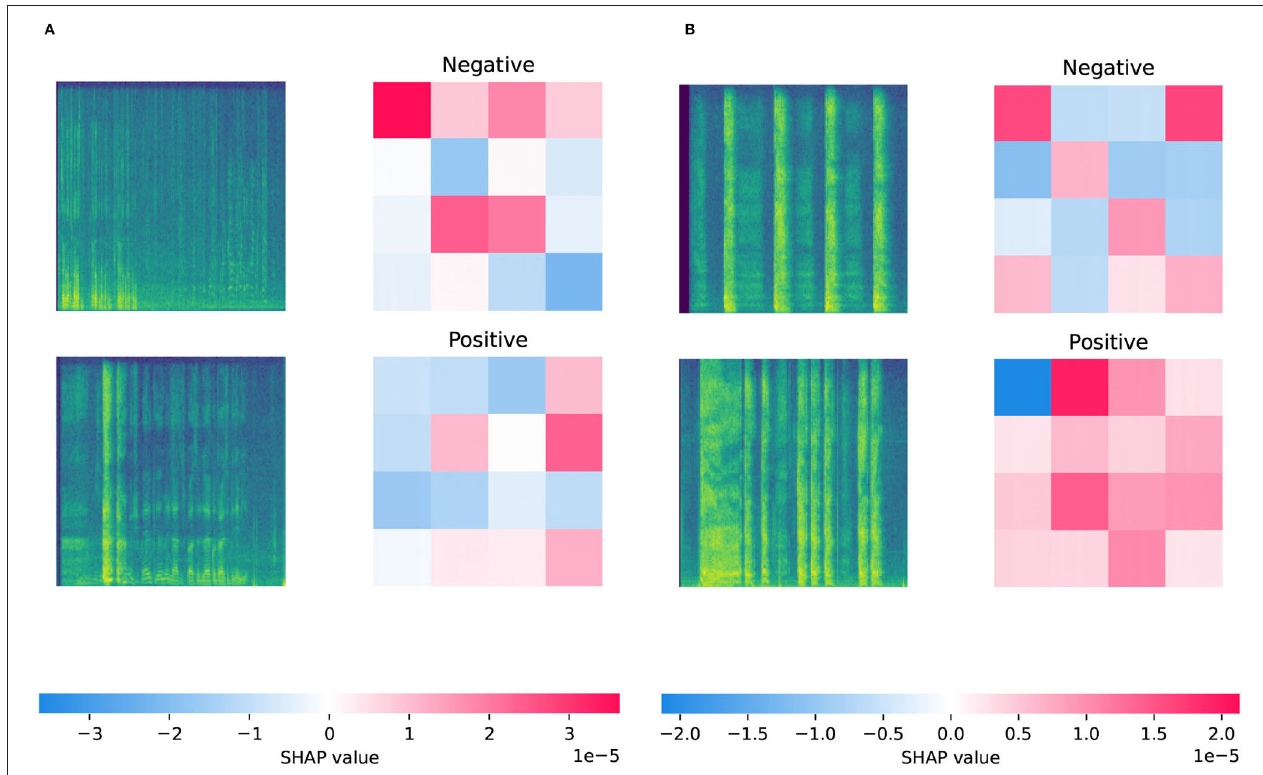
FIGURE 2 | Visualization of the SHAP outputs for sample Mel spectrograms from negative and positive classes of CSS and CCS datasets. The x-axis of the spectrograms represents time [0–5s] and the y-axis represents the frequency [0–4,096Hz]. The range of the SHAP values for each model’s output is given in the color bar below each image. Areas that increase the probability of the class are colored in red, and blue areas decrease the probability. A detailed account of the spectrogram and SHAP values analysis is given in Section 3.5. (A) SHAP outputs from the COVID-19 speech (CSS) model. (B) SHAP outputs from the COVID-19 cough (CCS)